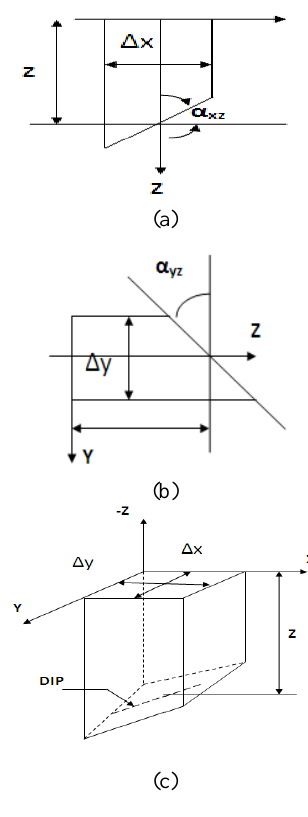
Figure.3: Section(a,b), and Three-Dimensional Views of one Soil Column Hovalnd